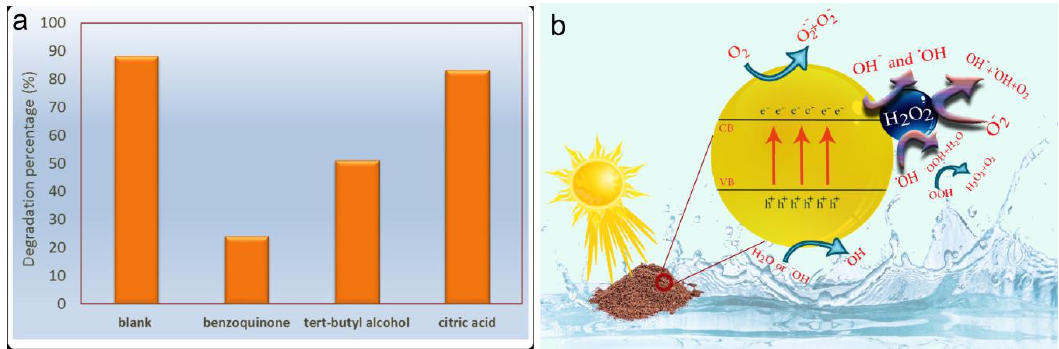
Figure 8. The temporal changes in the fluorescence intensity of 2-hydroxyl-terephthalic acid upon irradiation with UV light (290 nm) in the presence of S 4 .